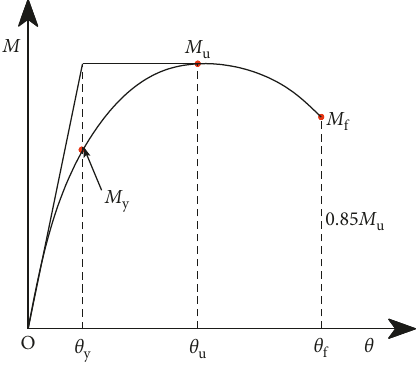
Figure 9: Key parameters in the moment-rotation relationship of specimens.